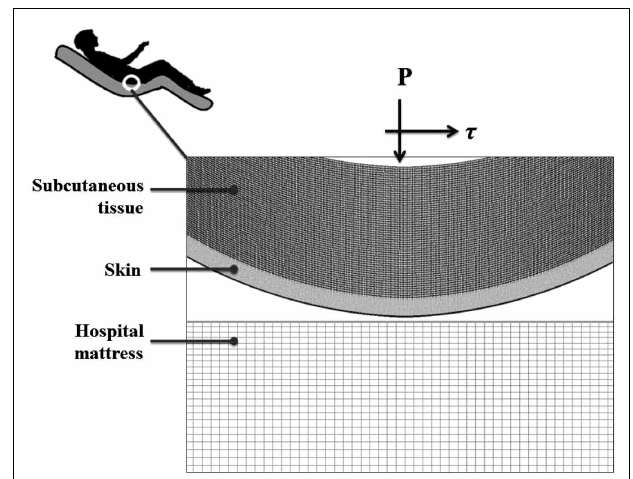
FIGURE 1 |The model of the skin in interaction of the hospital mattress .